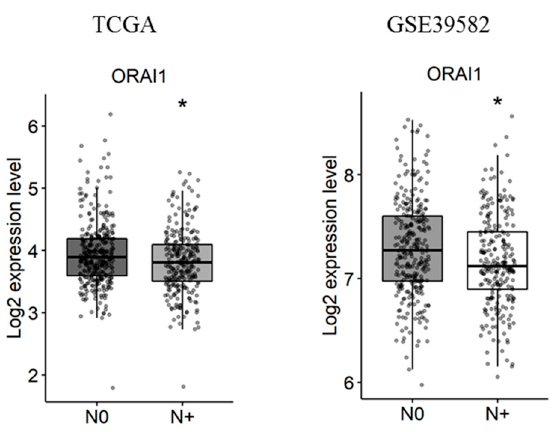
Figure 4. ORAI1 is downregulated with lymph node metastases in TCGA and GSE39582 datasets. N0 represents tumors with no lymph node metastases and N + represents tumors with N1 or N2 lymph node metastases. The student’s t -test was used for pairwise comparison. (* p < 0.05). TCGA: The Cancer Genome Atlas.